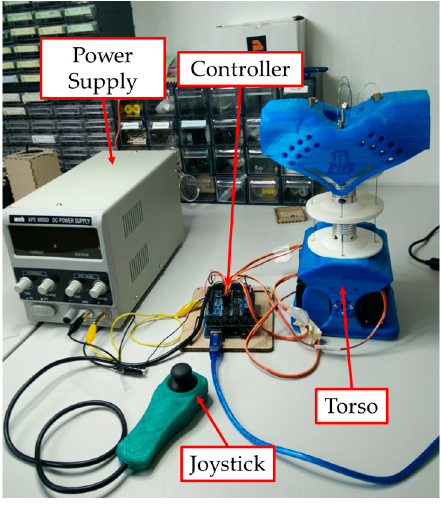
Figure 7. Experimental setup for the validation of the proposed kinematic model, including the torso mechanism, an Arduino microcontroller, a joystick for teleoperation, and a power supply.